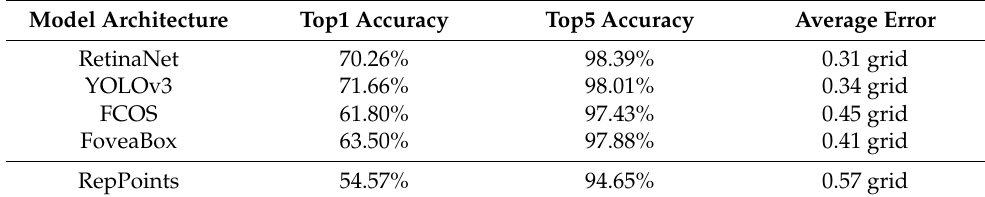
Table 4. Vanishing Point Detection